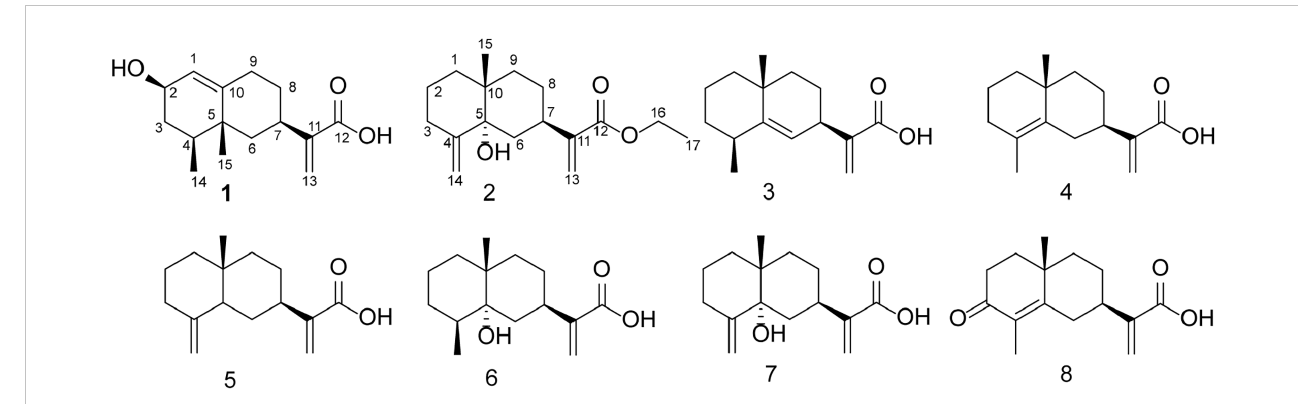
FIGURE 3 Chemical structures of the eight